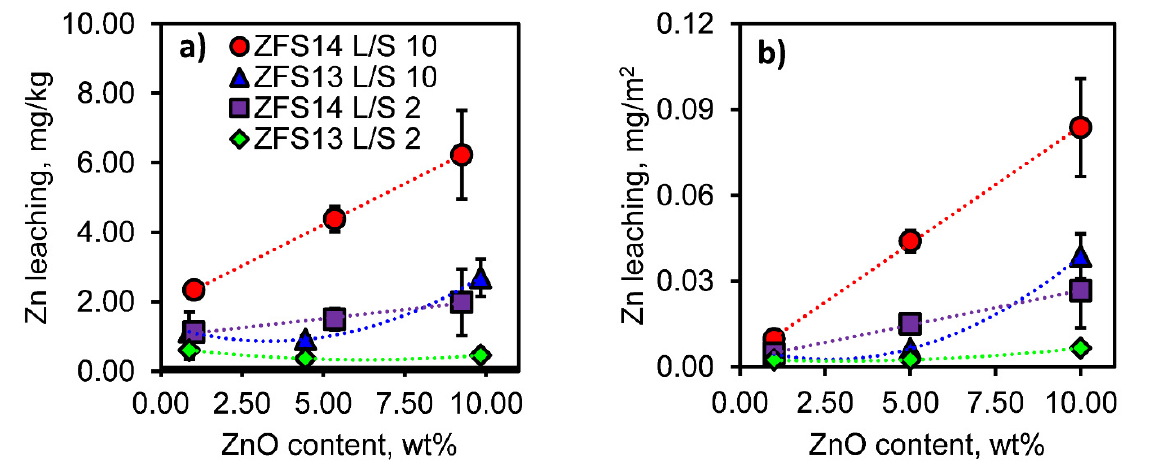
Figure 4. Zn leaching according to EN12457-3 versus normalized ZnO content in the ZFS samples: ( a ) mg/kg and ( b ) mg/m 2 .